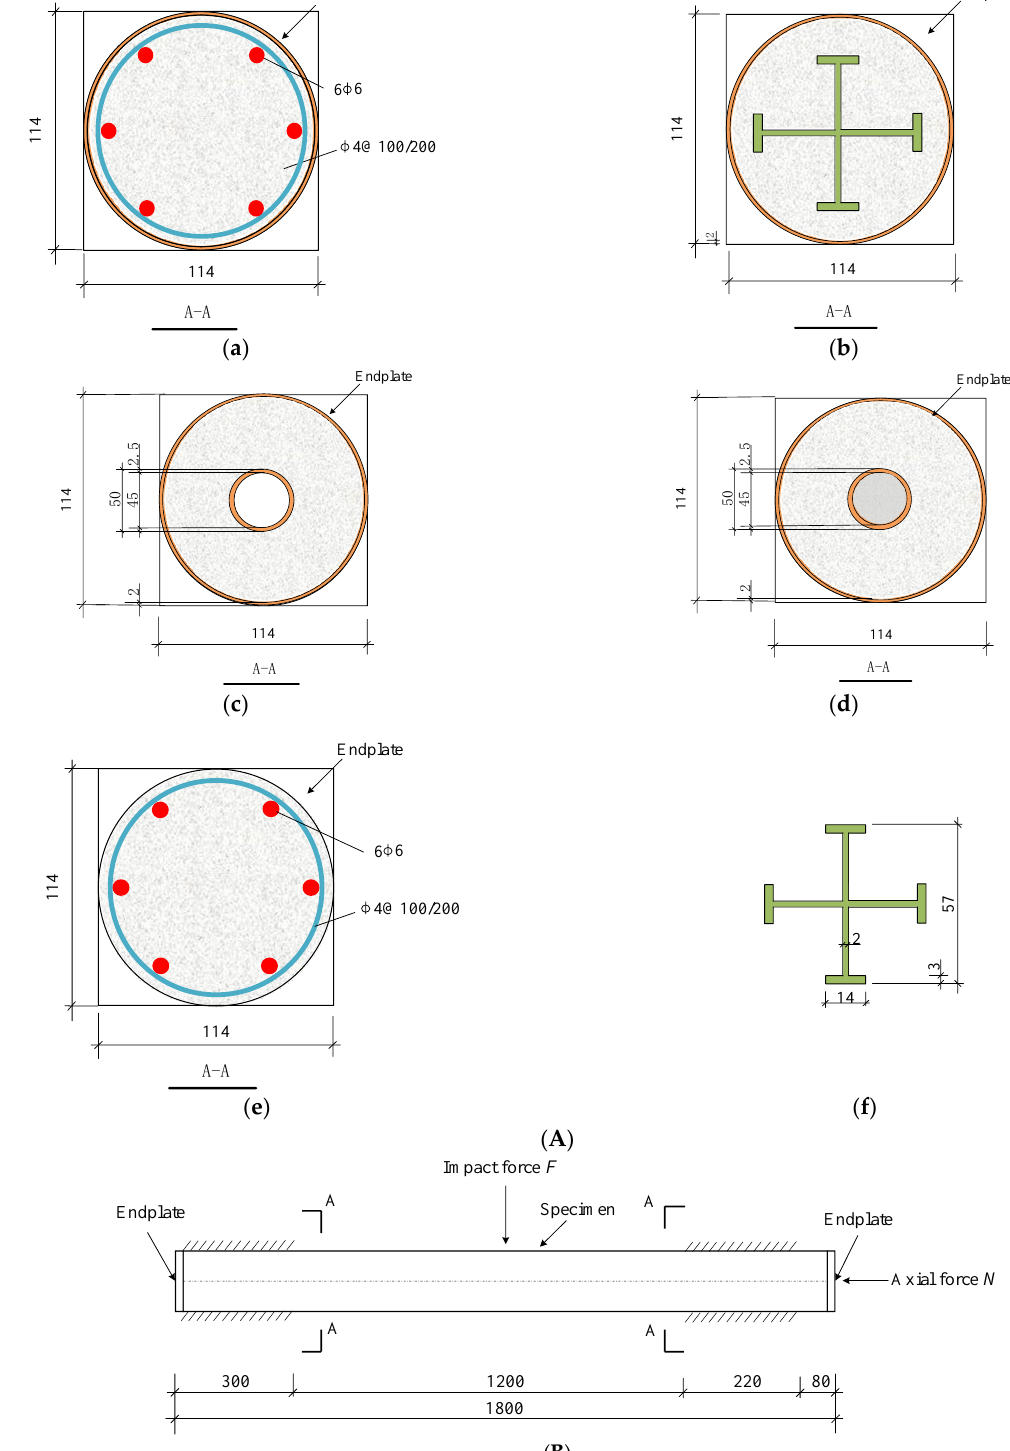
Figure 1. ( A ) Dimensions of the specimens (unit: mm). ( a ) Section of R-ST columns; ( b ) Section of S-ST columns; ( c ) Section of H-DS columns; ( d ) Section of S-DS columns; ( e ) Section of RC columns; ( f ) Section dimensions of the double H-shaped steel. ( B ) Plan view of the specimens.